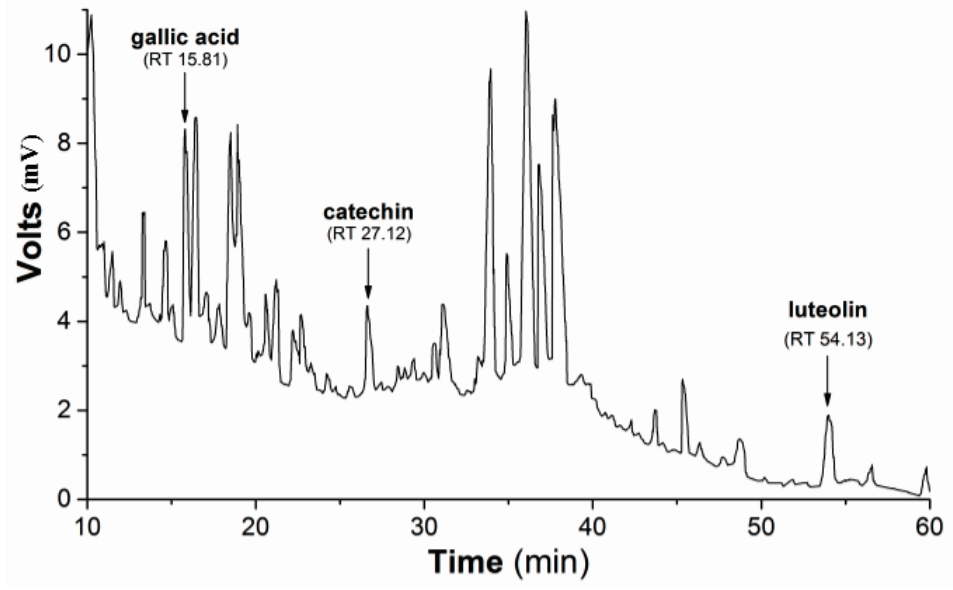
Figure 1. HPLC separation profile of P. major hydroethanolic extract . Representative chromatogram of the isolated compounds/fractions with detection at 245 nm. Peaks indicate the retention times of some flavonoids, which were identified by comparison with flavonoid